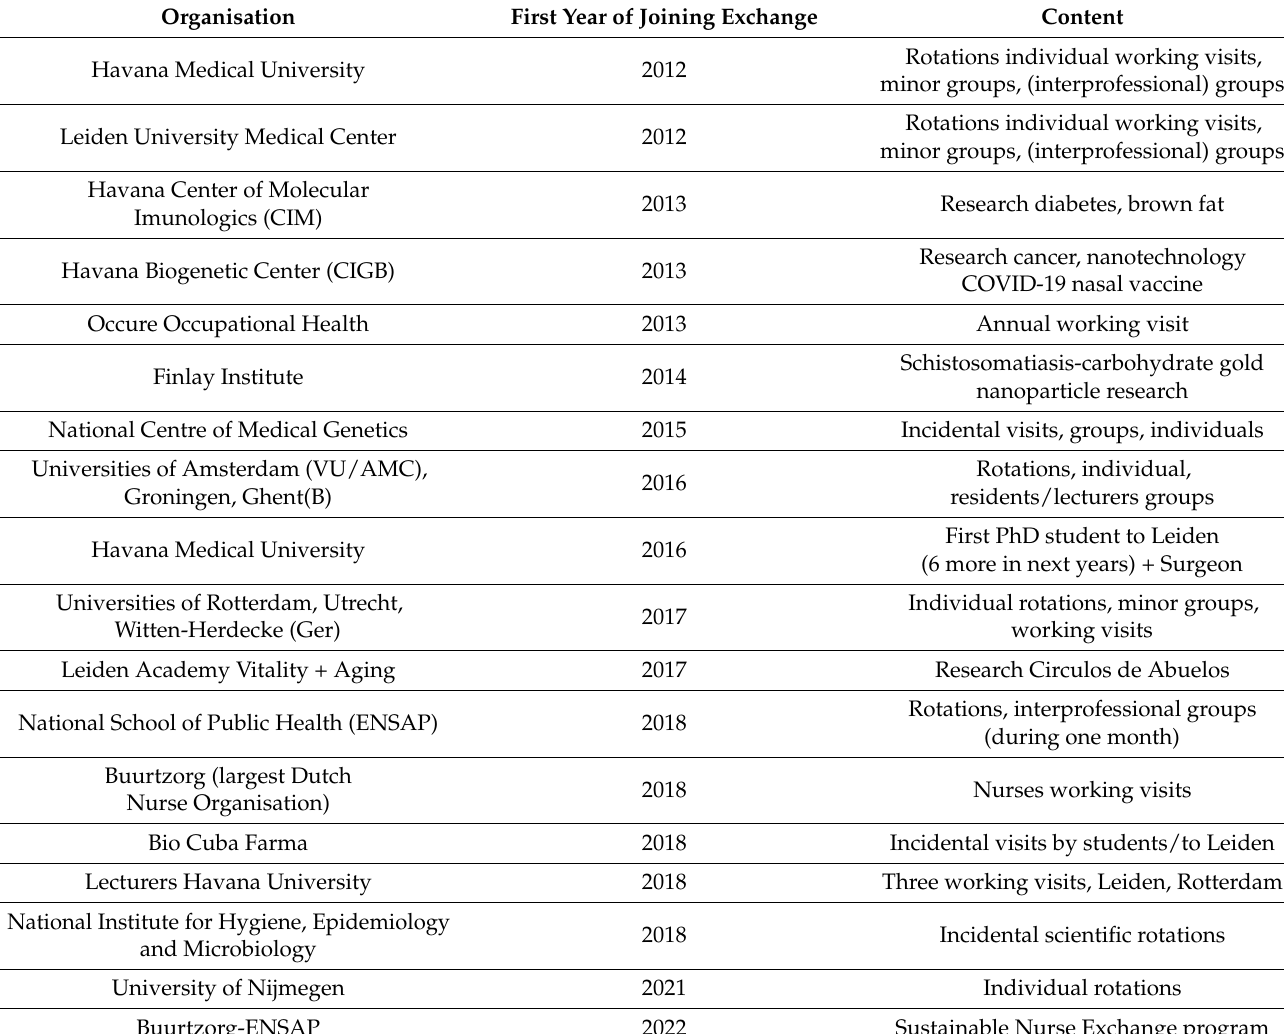
Table 1. Cuban–Dutch Medical Educational and Scientific Capacity Building,